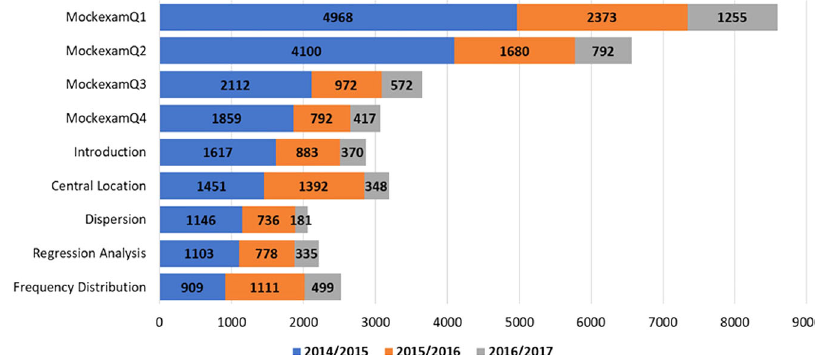
Fig. 7 Learner engagement with VBL during module delivery (2014 – 2017). Results from an analysis of the learner viewing frequency of videos during curriculum delivery